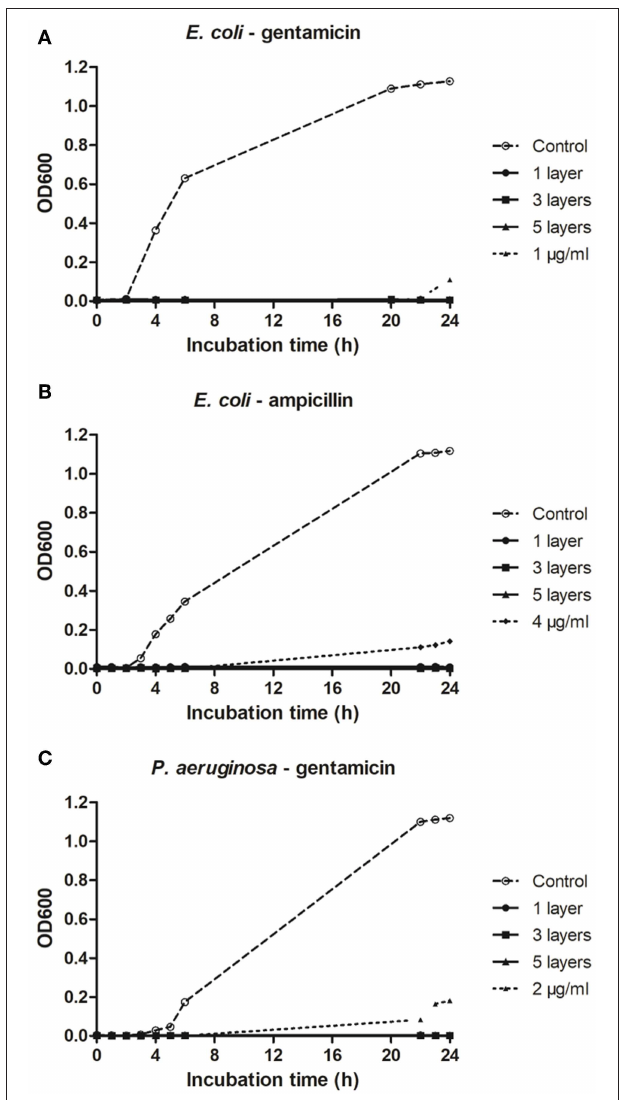
FIGURE 4 | Effect of plasma deposited antibiotics on micro-titer plates on growth of planktonic E. coli and P. aeruginosa. (A,B) Growth of E. coli on microtiter plates deposited with ampicillin and gentamicin, respectively. (C) Growth of P. aeruginosa on microtiter plates deposited with gentamicin.